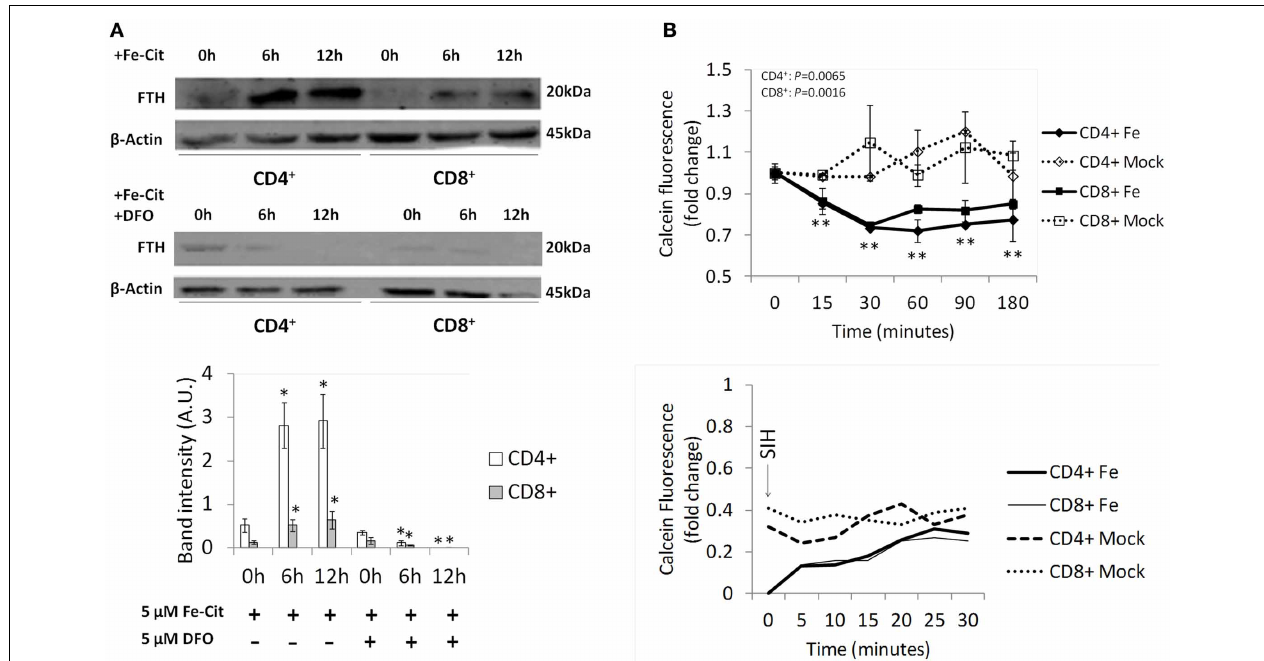
FIGURE 1 | NTBI storage by T lymphocytes. (A) Regulation of Ferritin H expression by NTBI in T lymphocyte populations. Western blot quantification of Ferritin H (FTH) expression in CD4 + and CD8 + cells incubated with 5 μ M of Fe-citrate (upper panel) or Fe-citrate + 5 μ M DFO (middle panel) for 0–12h. β -actin expression was used as loading control. Images are representative of three experiments without significant inter-experimental variation. Bottom panel: Scanning densitometry of FTH Western blot. Data are normalized for β -actin levels and are expressed as arbitrary units (AU). ∗ P < 0 . 05 and ∗∗ P < 0 . 005 (One-Way ANOVA) between relative FTH levels at 0h and posterior time-points, for each population and experimental condition.